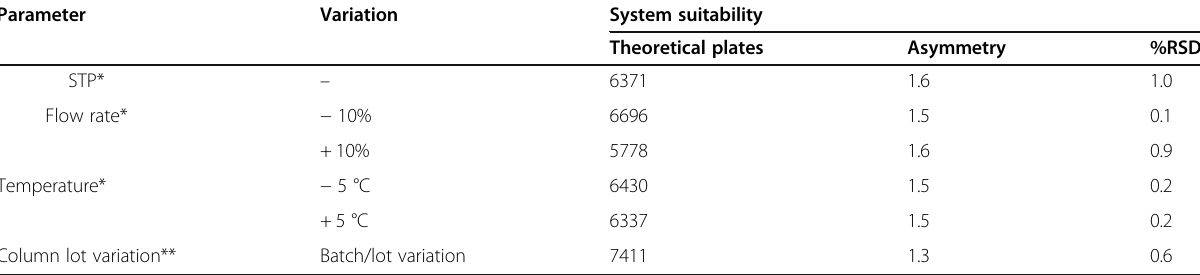
Table 6 Representation of overall statistical data of ruggedness Parameter